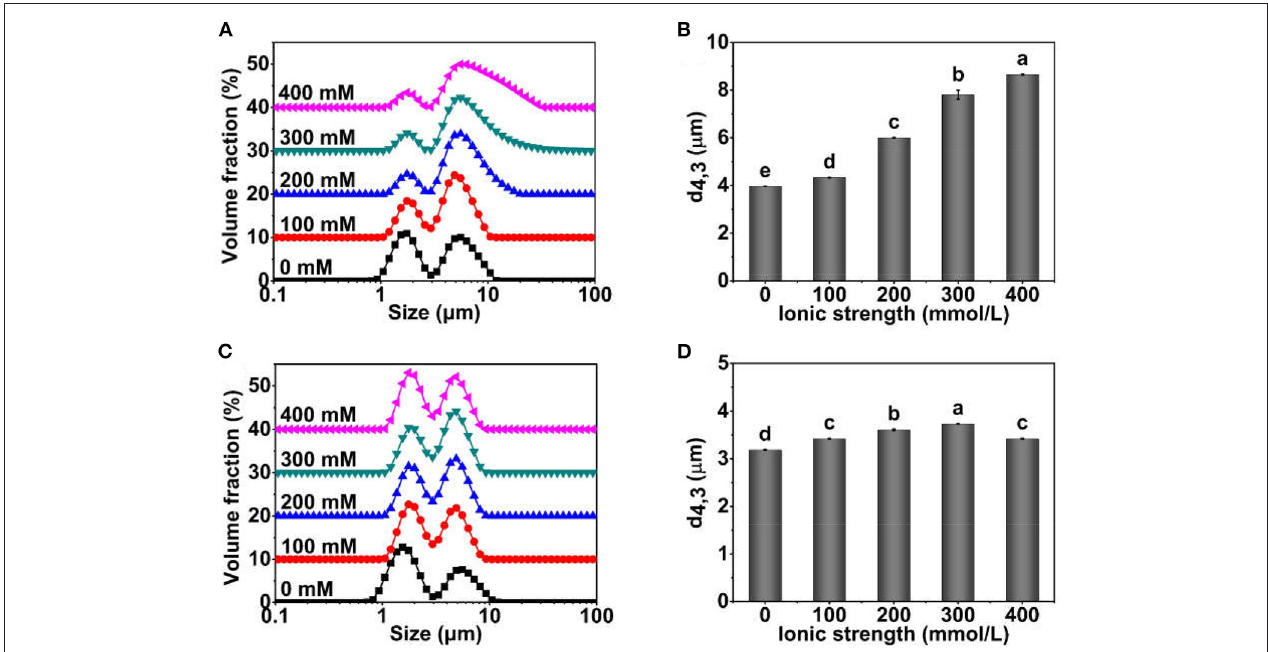
FIGURE 1 | Particle size distribution profiles and d 4,3 of Pickering emulsions stabilized by TWIPNs at different ionic strengths [ (A) Particle size distribution in water; (B) d 4,3 in water; (C) Particle size distribution in 1.0% SDS; (D) d 4,3 in 1.0% SDS]. The lowercases indicate the significance of different Pickering emulsions by tea water-insoluble protein nanoparticles under different ionic strengths ( P < 0.05).